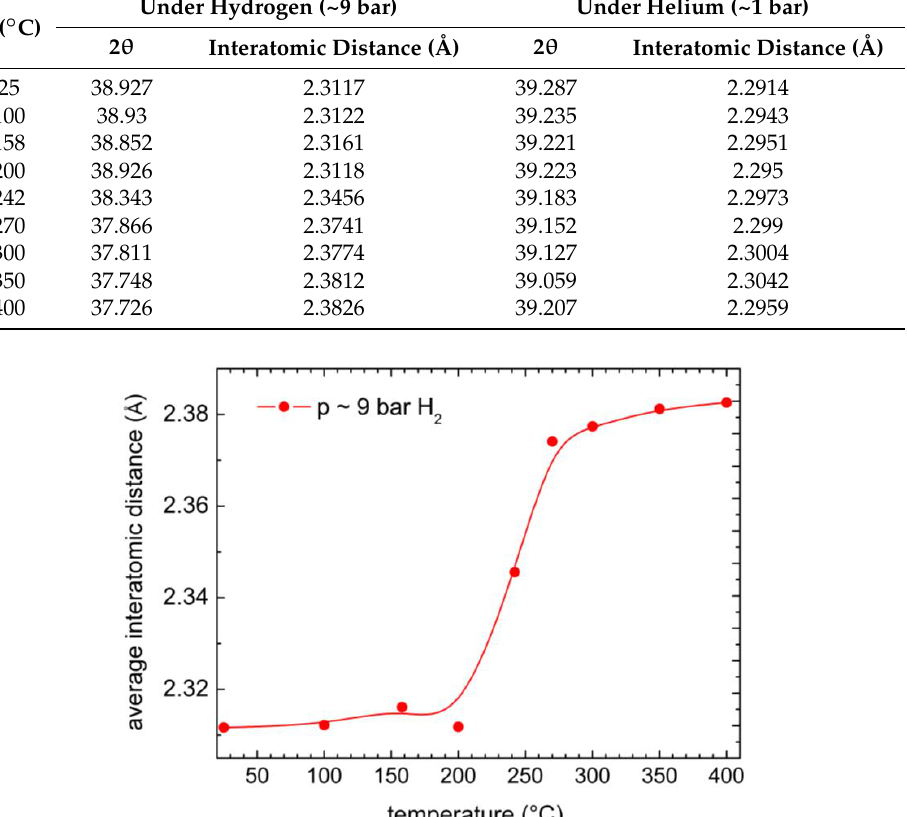
Figure 7. Average interatomic distances at the maxima of the X-ray diffraction peak (Figure 5) taken at 9 bar H 2 pressure.